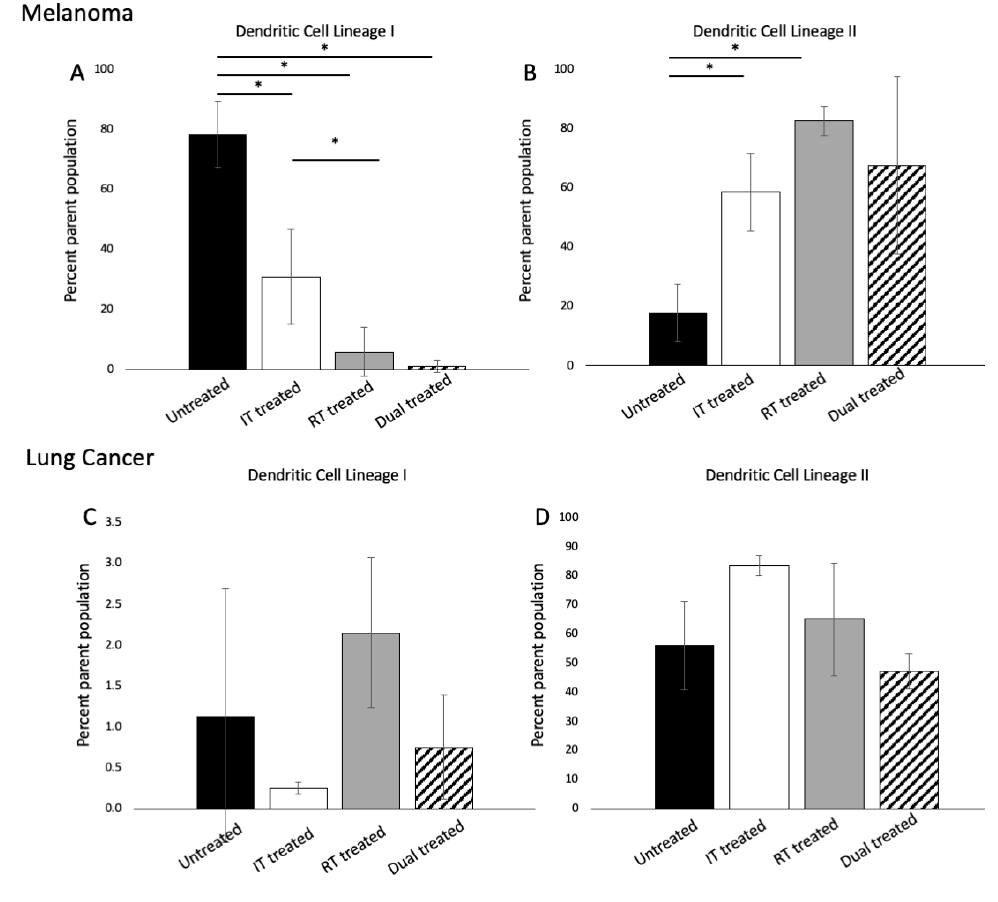
Figure 3. Flow cytometric analysis of conventional dendritic cell lineage I and II cells in melanoma ( A , B ) and lung cancer ( C , D ) demonstrated that response to therapy was tumor-dependent; in melanoma, there were significant differences among both populations based on treatment group whereas these differences were not observed in lung cancer ( n = 3 per group). Significant differences are marked with a line with an asterisk. (Dendritic cells: CD3 – /CD19 – /CD11c + /MHCII + ; conventional DC lineage I: CD3 – /CD19 – /CD11c + /MHCII + /XCR1 + /CD11b –/low , conventional DC lineage II: CD3 – /CD19 – /CD11c + /MHCII + /XCR1 – /CD11b +